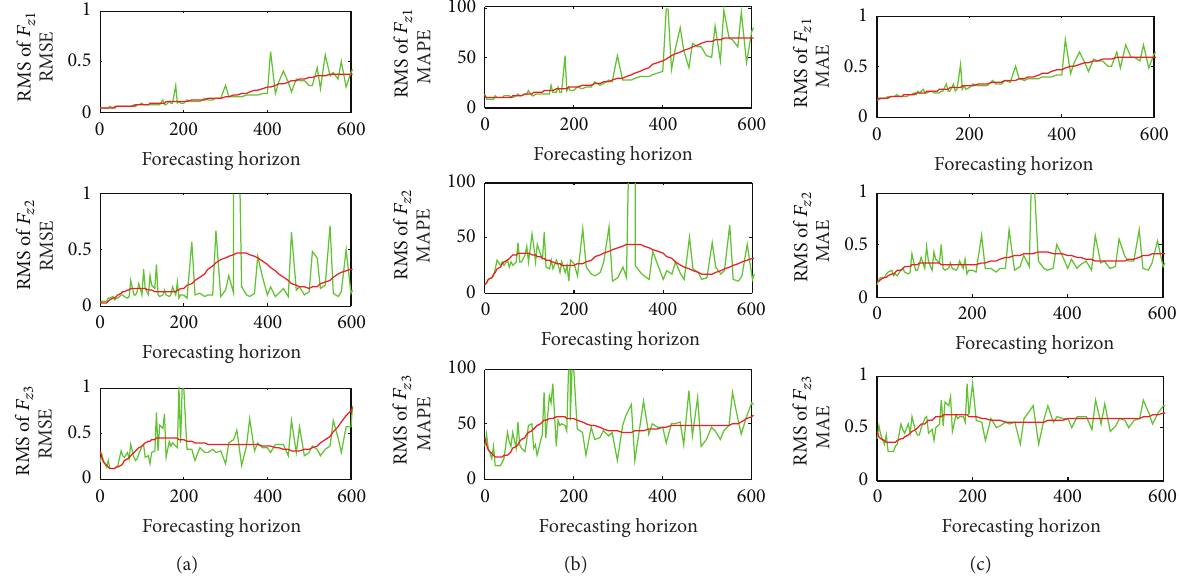
Figure 9: Study of the affectation of the forecasting horizon to the forecasting